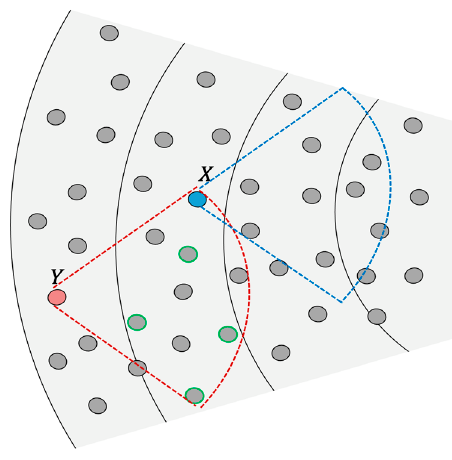
Figure 8. Forwarders selection.